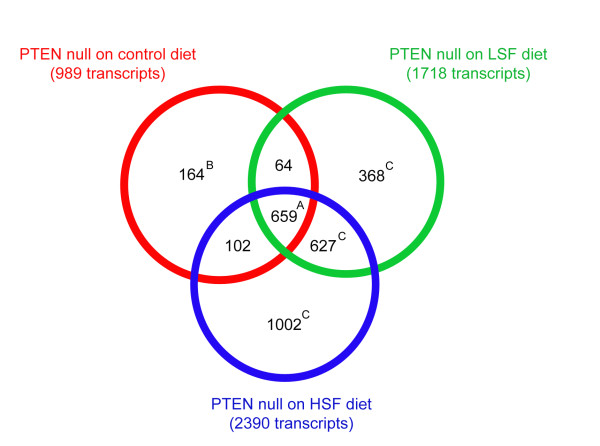
Comparison of gene changes in PTEN null mice on different diets compared to WT mice fed the control diet. Overlap of differentially expressed transcripts (P ≤ 0.05) of 8-week old PTEN null mice on the control diet (989 transcripts, 'PTEN signature transcripts', Table 1), low sulforaphane (LSF, 1718 transcripts, Table 1) and high sulforaphane (HSF, 2390 transcripts, Table 1) diet each compared to 8-week old WT mice on the control diet. A, Functional analysis by GenMAPP of these genes (data not shown) confirmed that they are enriched for genes involved in immune response, inflammatory response and response to wounding, two of which are common pathways between all three diets (Table 3). B, Details of these genes are shown in Additional file 3 - Table S3. C, Functional analysis of these genes is shown in Additional file 4 - Table S4.